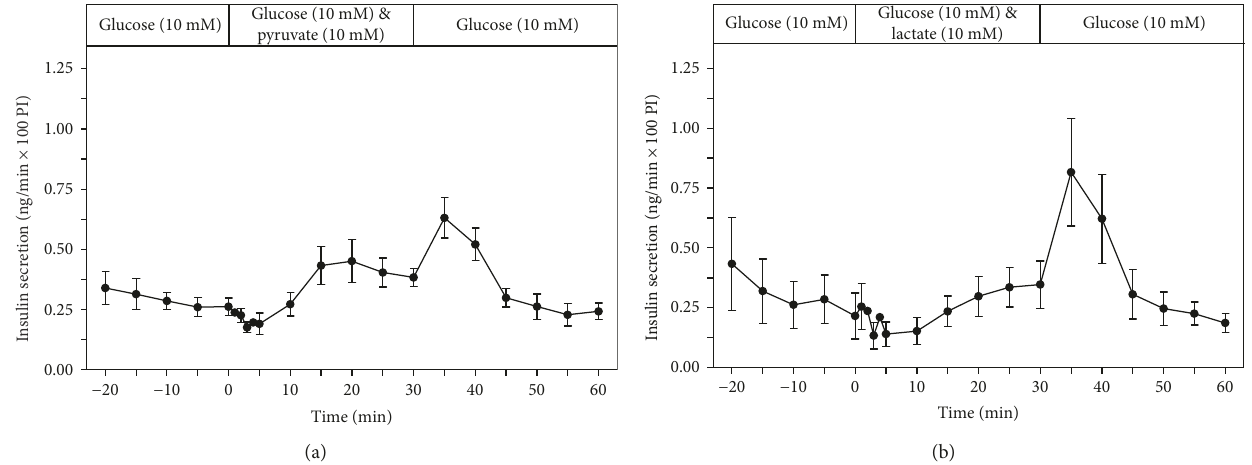
Figure 5: Kinetic pro fi les of insulin secretion from perifused EndoC- β H1 β -cell pseudoislets in response to a 30 min exposure to pyruvate (10 mM) (a) ( n = 4 ) or to lactate (b) ( n = 5 ), each in the presence of glucose (10 mM). After a 20min preperifusion phase with basal glucose (3 mM), a 30min stimulation period and thereafter a return of the perifusion to 10 mM glucose medium for another 30min are depicted. Shown are means ± SEM of insulin release rates expressed as ng/min and per 100 pseudoislets